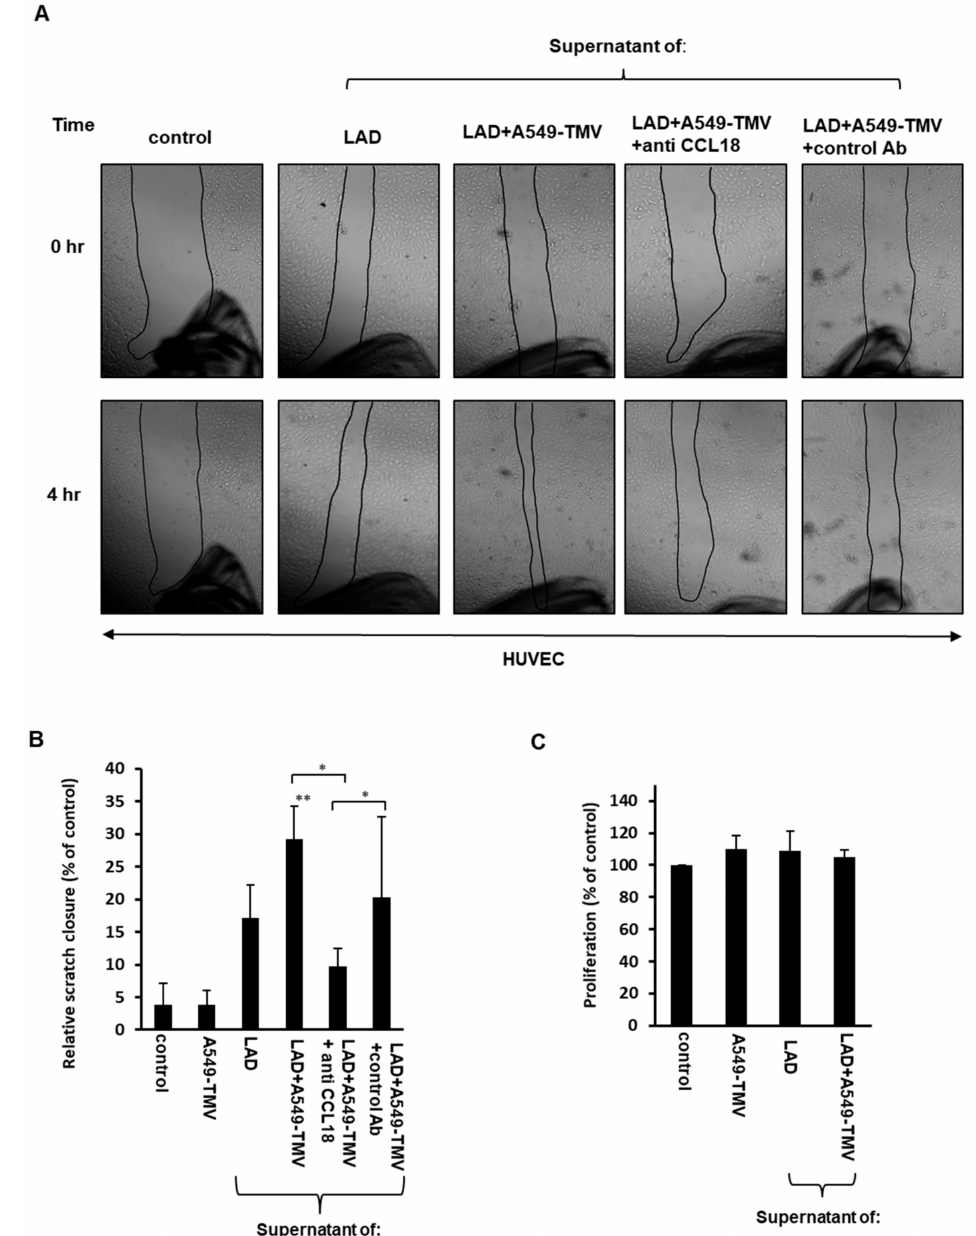
Figure 2. CCL18 released from NSCLC-TMV-stimulated mast cells induced HUVEC migration but not proliferation. ( A ) The effect of supernatants obtained from LAD2 cells activated by A549-TMVs on HUVEC migration was assessed by scratch assay. Scratch assay closure was photographed immediately (0 h) and after 4 h (magnification × 40). ( B ) Results are presented as percent of control in bar graphs. ( C ) The effect of supernatants obtained from LAD2 cells activated by A549-TMVs on HUVEC proliferation. Results are presented as percent of control. Data are presented as means ± SEs of three independent experiments done in duplicates (* p < 0.05; ** p <